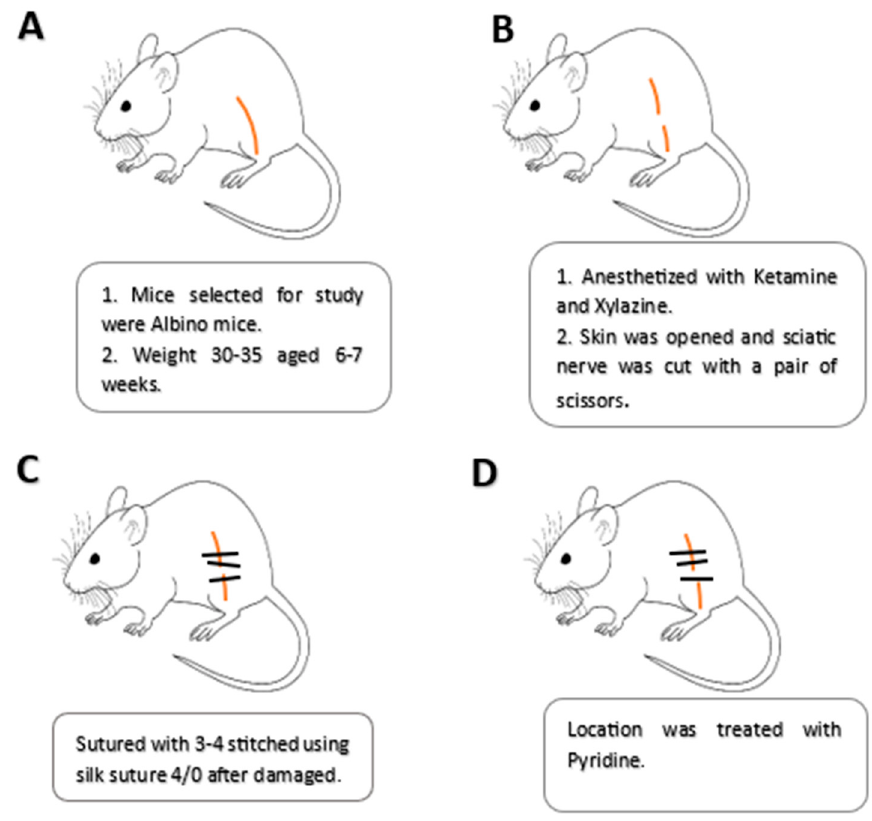
Figure 1. Characterization of nanosuspension of F. vulgare ( A ); TEM analysis ( B ); size distribution ( C ); FTIR analysis ( D